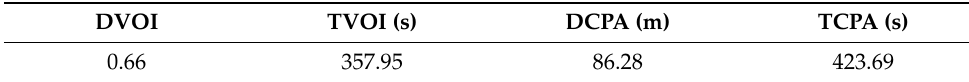
Table 8. AIS data of Case 4.